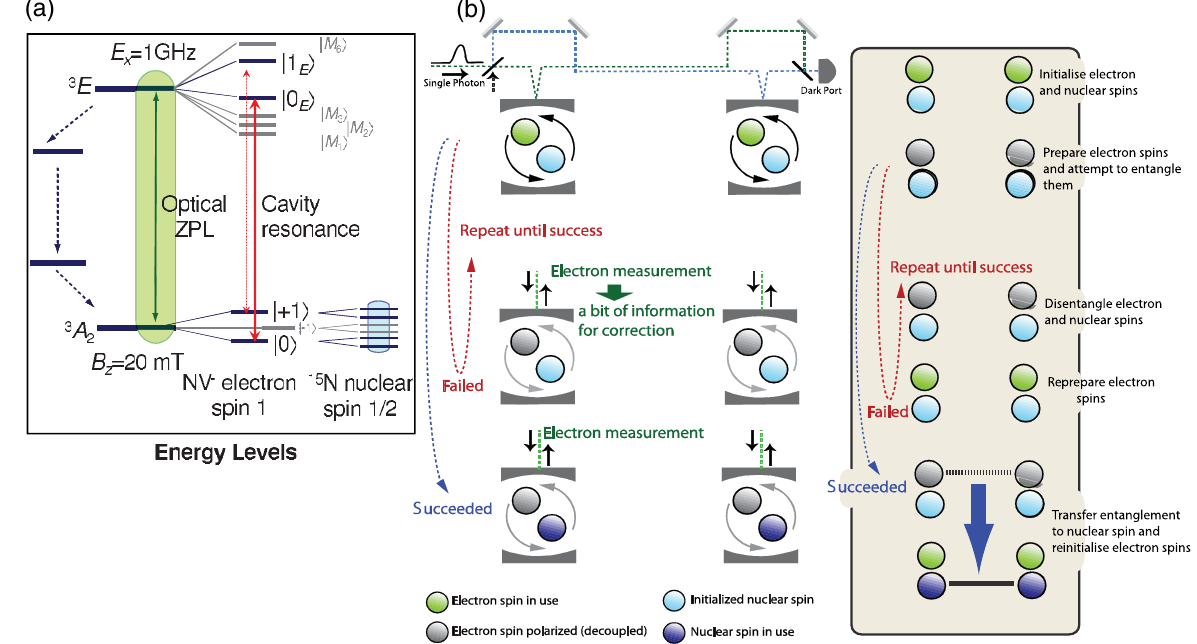
FIG. 2. NV − center is shown as a definite example of the artificial atom to realize the module. Its energy level structure for a low- temperature, low-strain sample [14,64] is illustrated in (a). A static magnetic field of approximately 20 mT is used to separate the 1 levels. The NV − center possesses both an electron spin and a 15 N nuclear spin, which will be used to store and grow a cluster m s ¼ (cid:1) state for quantum information processing. Panel (b) illustrates how the storage of entanglement in the nuclear spins is achieved. The protocol works as a repeat-until-success scheme for entangling the remote electron spins using a single photon – based Michelson interferometer. The successful event is the detection of a photon at the dark port. Once this has been achieved, the electrons are entangled with the nuclear spins followed by measurement of the electron spins to disentangle them. This allows our entanglement of the electron spins to be transferred to the nuclear spins [7]. Otherwise, the electron and nuclear spins will be decoupled completing the entangling cycle, only the electron spin reinitiated, and the protocol started